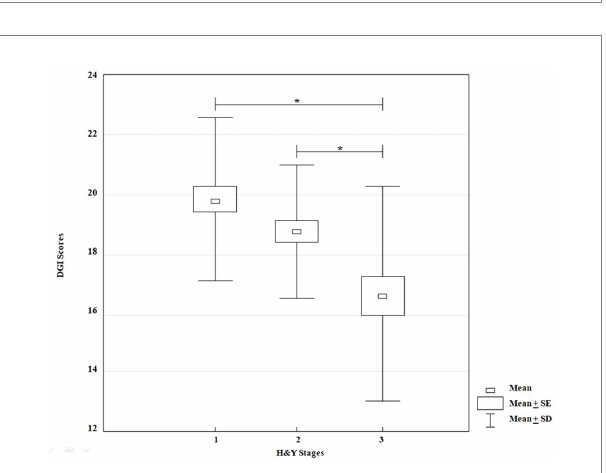
FIGURE 4 KW-ANOVA, demonstrating differences in the DGI scores between groups 1 and 3 and between groups 2 and 3.